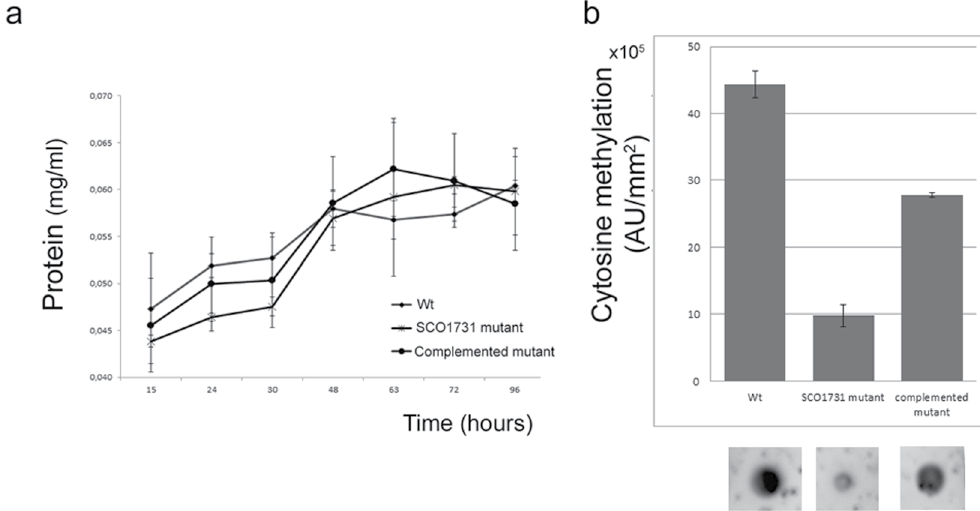
Figure 4. Growth and cytosine methylation of the S . coelicolor wild-type strain, the SCO1731::Tn5062 mutant and the complemented SCO1731::Tn5062 mutant, in sucrose-free R5A cultures. ( a ) Growth curves. ( b ) cytosine methylation levels at 20-hours (MI). AU indicate arbitrary units of methylation levels. The full length blots are included as Supplementary Fig. S9.